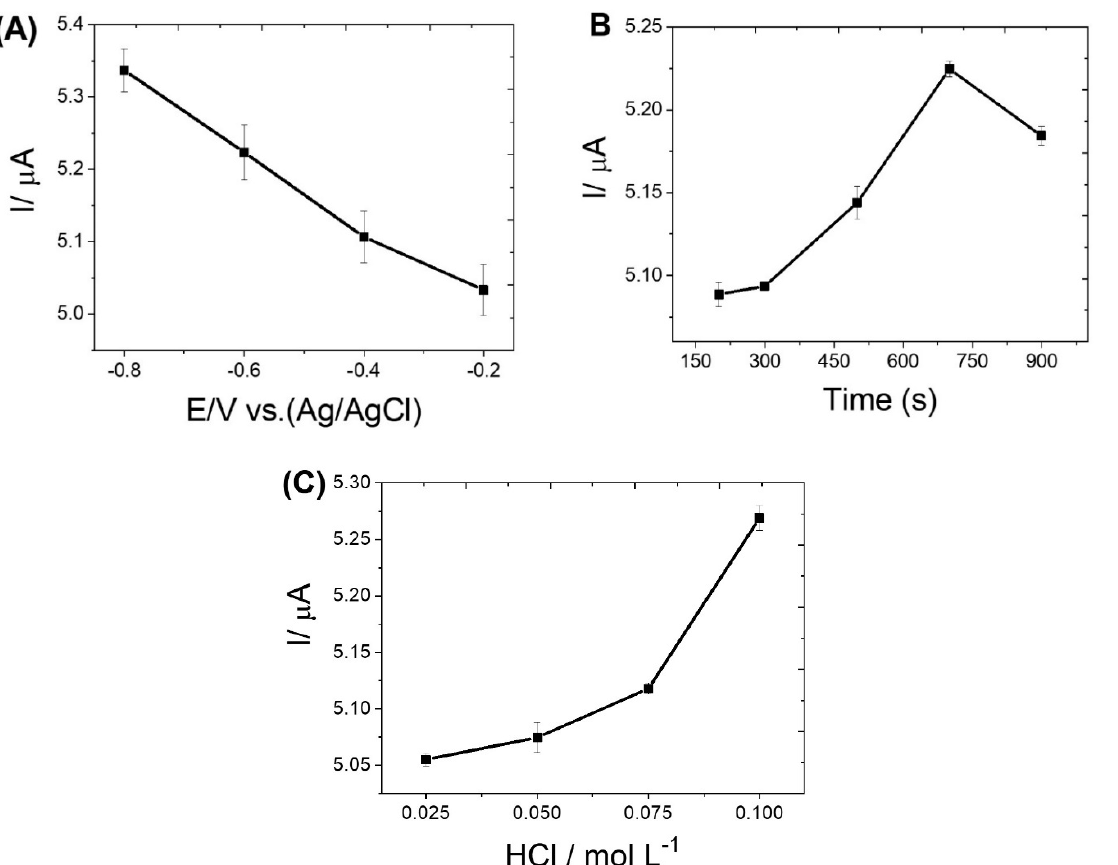
Figure 3. The influences of: ( A ) pre−concentration potential; ( B ) pre−concentration time; and ( C ) hydrochloric acid concentration on the peak current of 600 µg L –1 MeHg.